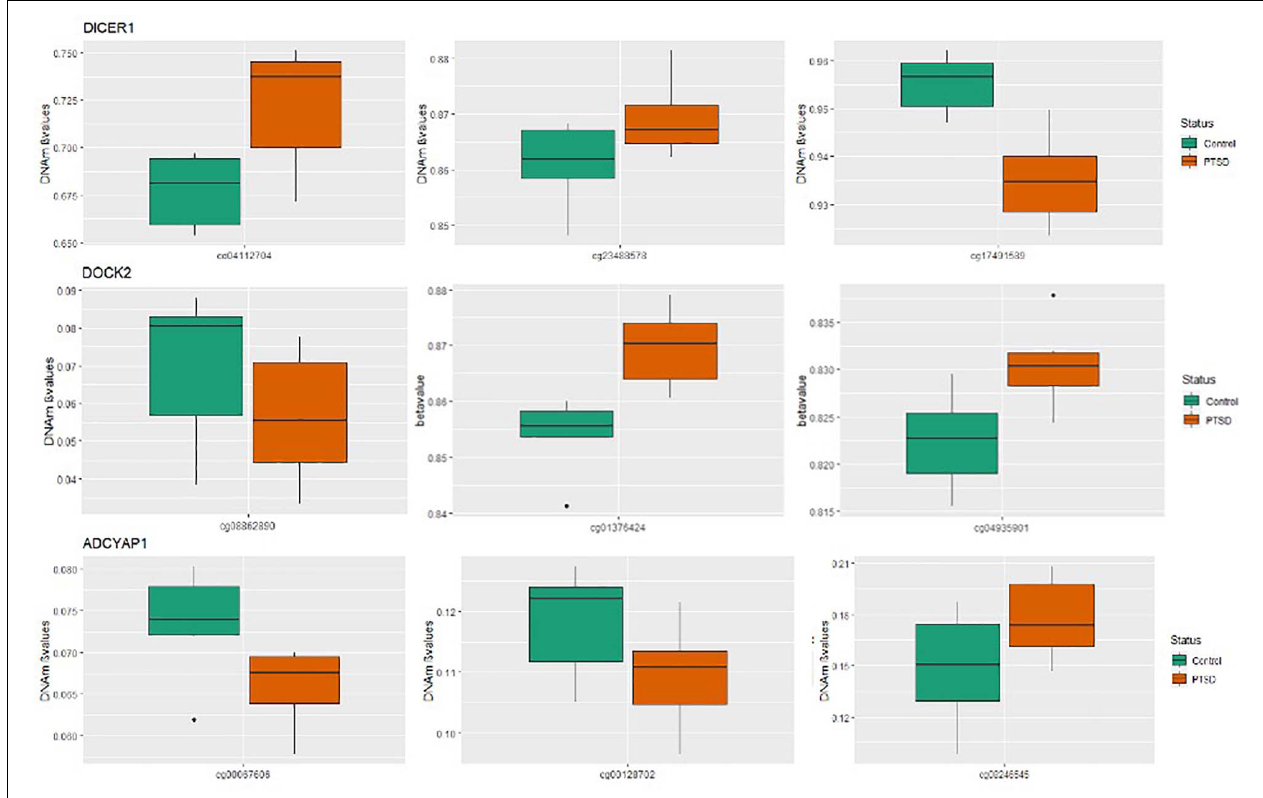
FIGURE 1 | Boxplots for significant PTSD candidate genes: Box plots of DNA methylation level beta-values at significant candidate genes for PTSD versus non-PTSD (control) MZ twins that were significant at gene-wise Bonferroni correction. The mean DNA methylation is higher in PTSD than in controls for two of the three CpGs for DICER and DOCK2, while ADCYAP1 has only one CpG with a higher mean DNA methylation in individuals with PTSD compared to control twins. The remainder of the CpGs have a higher mean DNA methylation in controls than with PTSD.